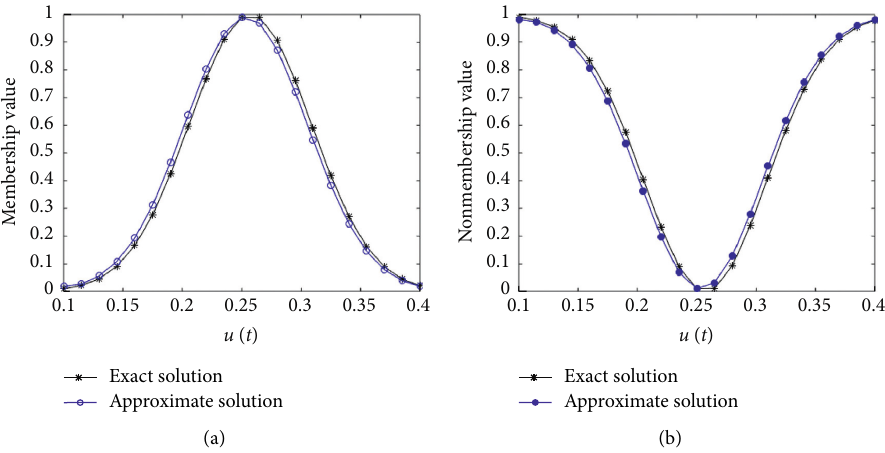
Figure 1: Exact and approximate solutions for membership and nonmembership functions at t � 1 and m � 4. –0.200.20.40.60.811.2